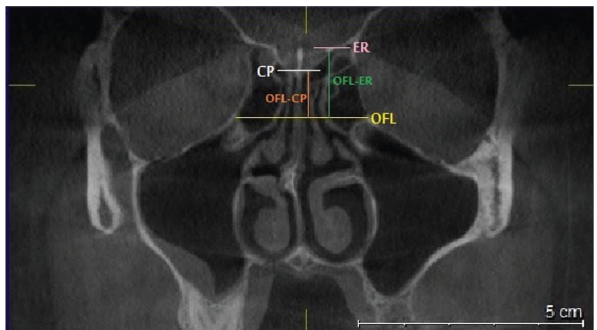
Figure 7: Coronal plan of CBCTdemonstrating landmarks of TMS classification: orbital floor (OFL): yellow line, cribriform plate (CP): white line, ethmoid roof (ER): pink line, OFL-CP: orange line, OFL-ER: green line.